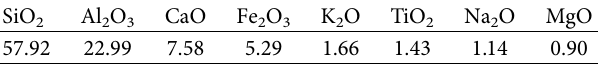
Table 1: Chemical composition of coal gangue (%).